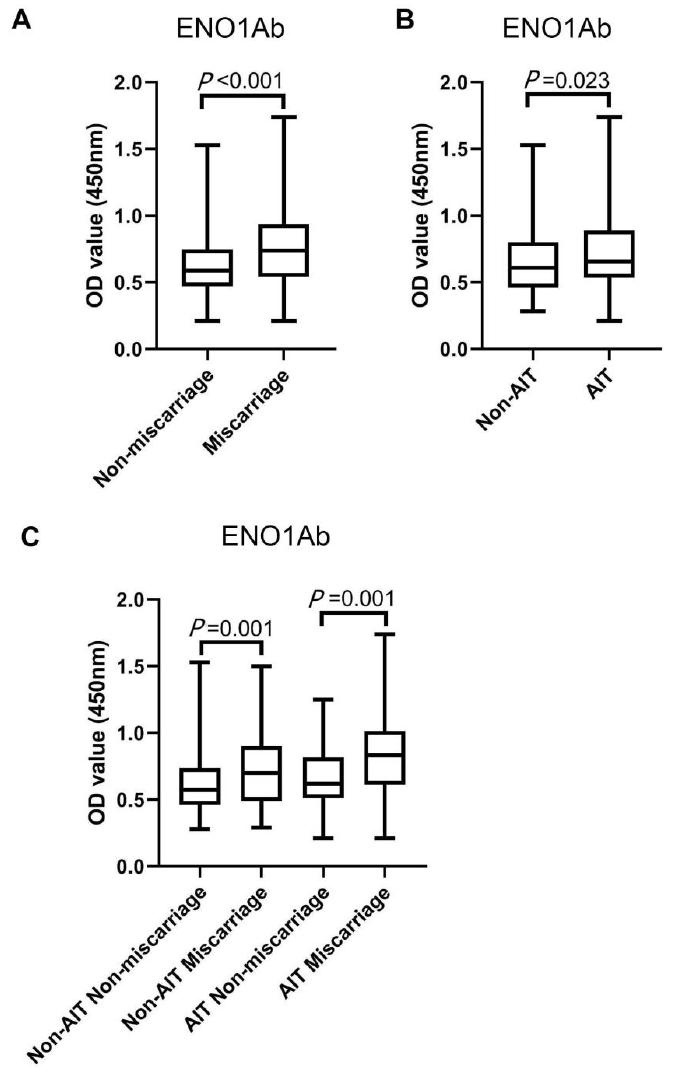
Figure 1. The serum levels of ENO1Ab in all euthyroid participants. The Mann–Whitney U test was performed to compare the serum levels of ENO1Ab between ( A ) participants with ( n = 144) and those without miscarriage ( n = 288), ( B ) participants with ( n = 144) and and those without AIT ( n = 288), ( C ) non-AIT participants with ( n = 96) and those without miscarriage ( n = 192), and AIT participants with ( n = 48) and those without miscarriage ( n = 96). The serum levels of total IgG against ENO1Ab were detected using enzyme-linked immunosorbent assay (ELISA) and expressed by absorbance at 450 nm. All data were exhibited as medians (P25 and P75), together with the minimum and maximum values in the box plot.